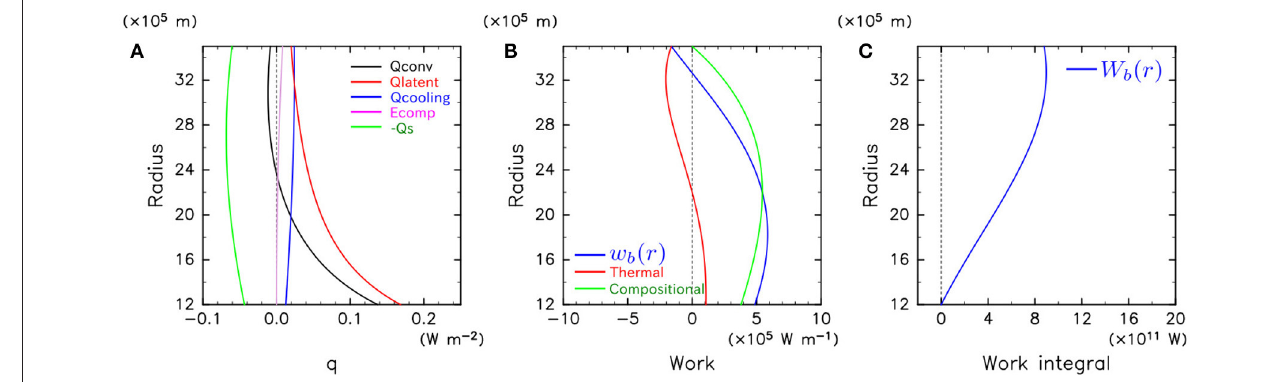
FIGURE 3 | As in Figure 2 but for Q CMB = 8TW.